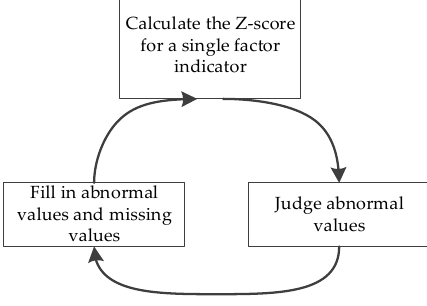
Figure 4. The procedures for preprocessing abnormal values.